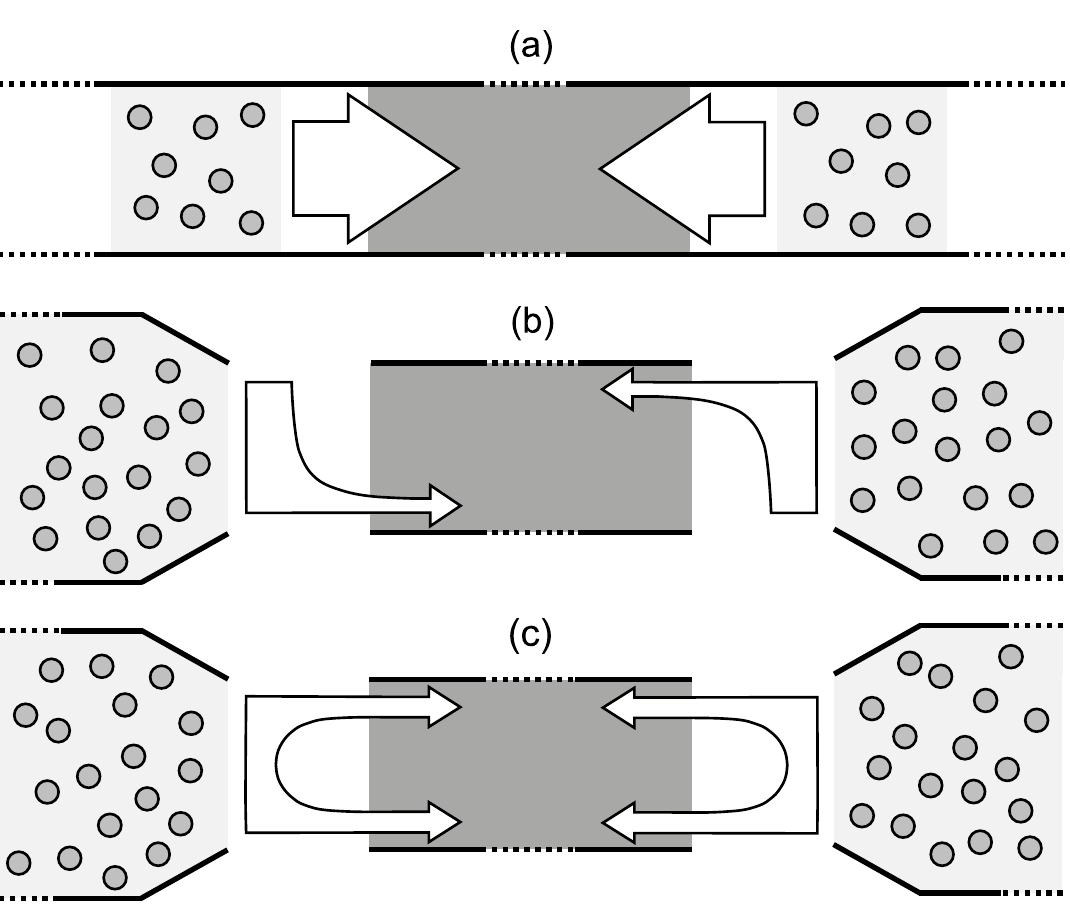
Fig 3. Types of bidirectional flows considered in this work. (a) represents a class of supervised experiments with a limited number of participants naturally interacting while walking through a long corridor (people kept walking even after passing the central area). No specific instructions were given on how to behave but participants were asked to simply walk. (b) represents experiments with a larger number of people flowing into a shorter corridor for 1–2 minutes with free choice to leave either side (right/left) at the exit. In this case, participants were allowed to exit the corridor from the side they liked and experiments were repeated under very similar conditions. Most people left from the right side as experiments were repeated (probably because of their daily custom). (c) represents a class of experiments where half of the participants were asked to exit from the left side and half from the right side. Strong interactions were observed as lane formation was clearly obstructed due to the specific instructions